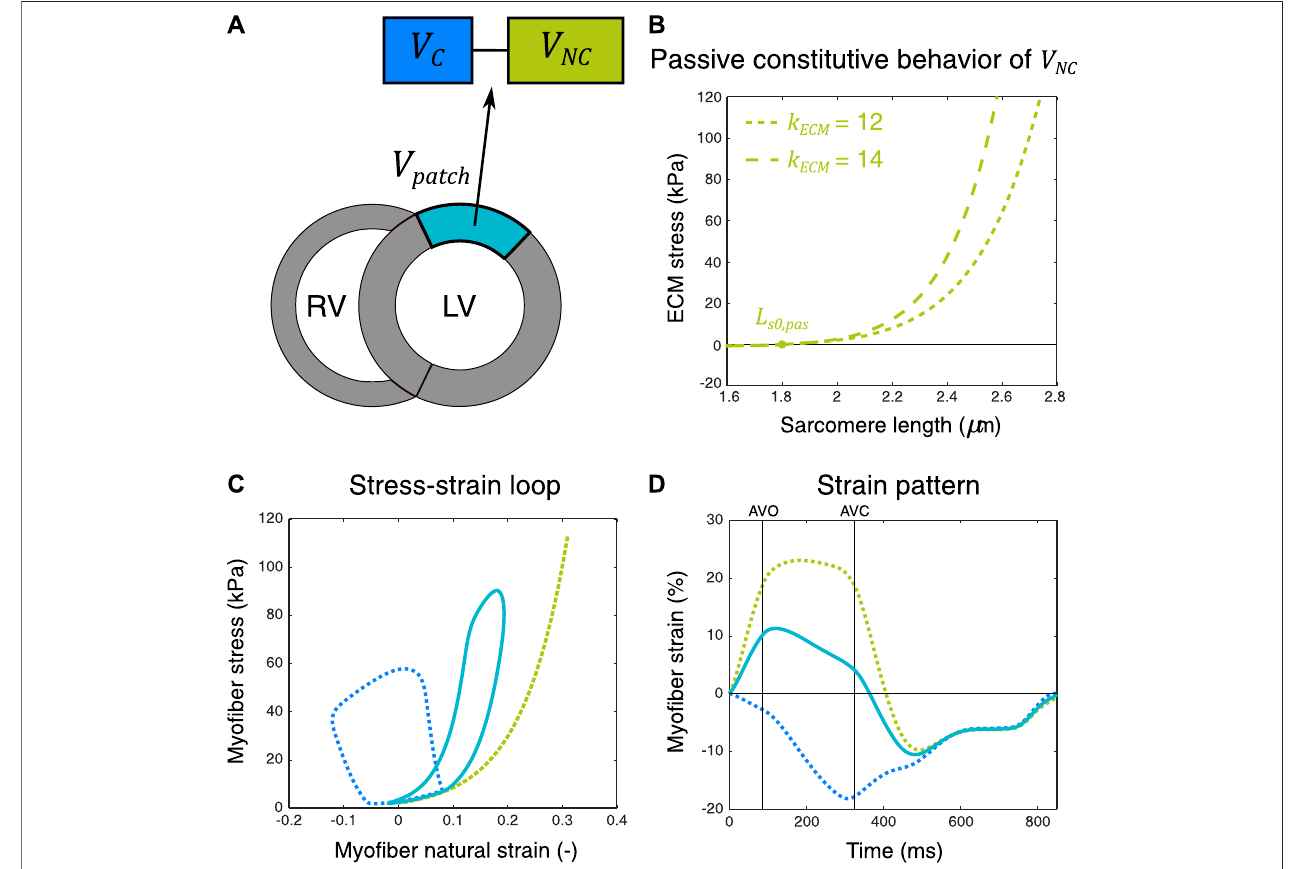
FIGURE 1 | Schematic representation of the two-compartment modeling approach used for simulation of ischemic myocardial dysfunction. A myocardial patch with volume V patch was subdivided into a hypothetical contractile and noncontractile patch (i.e., compartment) with volumes V C and V NC , respectively, being serially coupled (A) . Myocardial volume V C generated active stress, while V NC was passive (C) . Myocardial stiffness was determined by passive constitutive behavior of V NC , determinedbythezero-passivestresssarcomerelength( L s 0 , pas )andnonlinearity parameter( k ECM ) (B) .Theresultingstrainpatternof V patch (D) anditsstress – strain loop (C) were calculated from the volume-weighted average sarcomere length and stress of V C and V NC . AVO, aortic valve opening; AVC, aortic valve